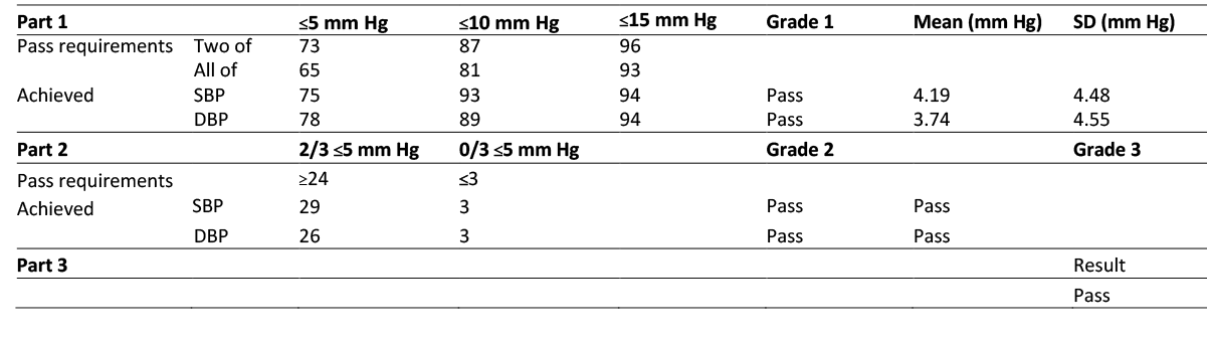
Figure 1. Validation results for the iHealth Track blood pressure device according to European Society of Hypertension International Protocol revision 2010 (ESH-IP2). Accuracy is determined by the number differences in these ranges both for individual measurements (Part 1) and for individual subjects (Part 2). To pass, a device must achieve all the minimum pass requirements shown. Pass requirements are as required by the EHS-IP2; achieved are as recorded by the device. DBP: diastolic blood pressure; SBP: systolic blood pressure.